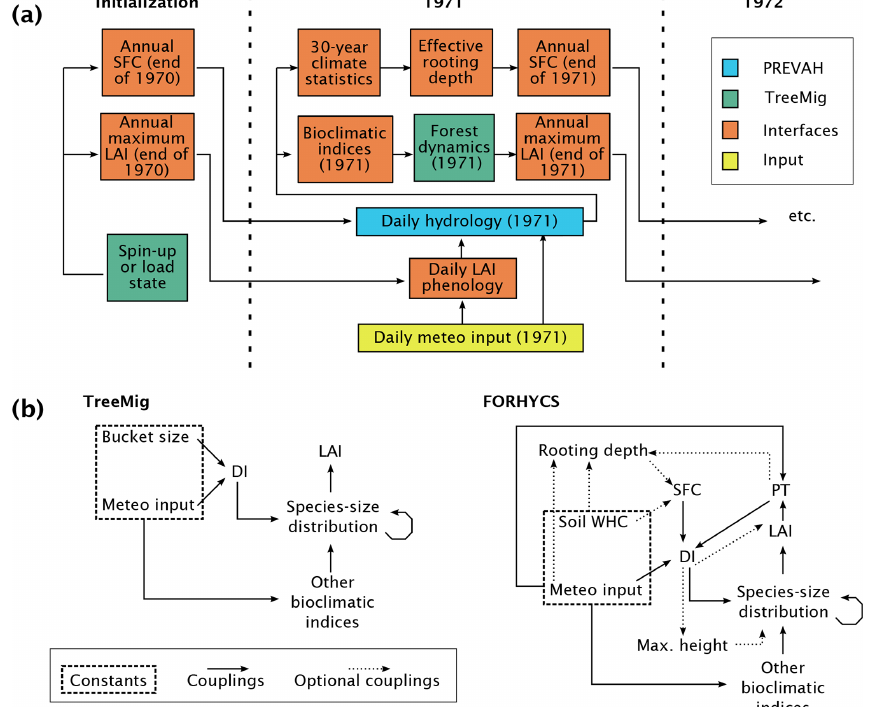
Figure 1. (a) Flow of a FORHYCS simulation starting in the example year 1971. The initial state can be loaded from a file or a spin-up can be performed. The hydrological calculations are performed daily. At the end of the simulation year, bioclimatic indices are calculated and passed to TreeMig, which simulates forest dynamics with an annual time step. Long-term climate statistics are updated at the end of the year based on the daily calculations, and the effective rooting depth module is run with the updated climate indices. The forest model returns an annual maximal LAI value. To be used in hydrological calculations, this value is converted to daily values based on simulated leaf phenology. Another important interface variable is the rooting zone storage capacity SFC. (b) Schematic overview of the couplings between climate, above-ground forest structure, and the rooting zone in TreeMig (left) and FORHYCS (right). TreeMig’s forest structure (species–size distribution) depends on its previous state and is influenced by the annual bioclimatic indices. Unlike the other indices, which depend on meteorological input only, the drought index (DI) further depends on a constant soil moisture storage capacity (“bucket size”). In FORHYCS, the drought index further depends on canopy structure, through its influence on potential transpiration (PT). Additional optional couplings in FORHYCS are the dynamic simulation of a climate-dependent storage capacity of the rooting zone (through varying effective rooting depth), a limitation of maximum tree height under dry conditions, and a drought-dependent reduction of leaf